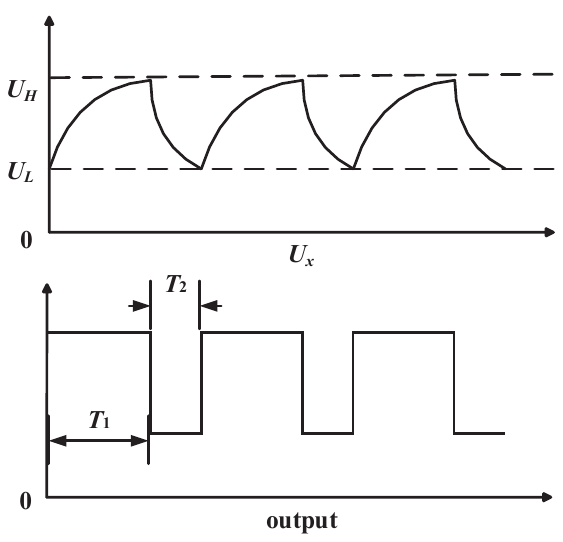
Figure 10. capacitance to period conversion circuit’s waveform.